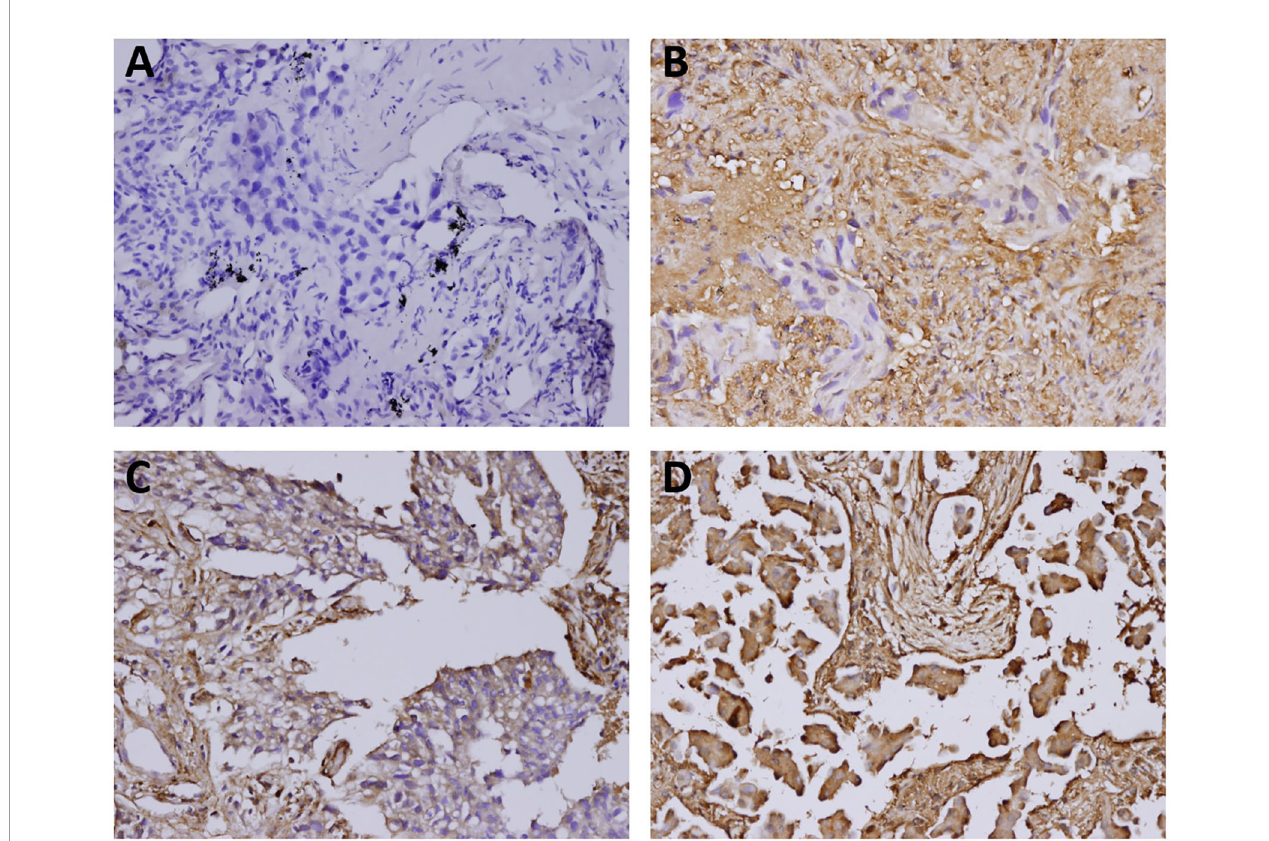
FIGURE 1 | The immunostaining features of tumor galectin-1 expression. The percentages of positive staining for galectin-1 in the tumor part were scored as follows: (A) Score 0 for <10% positive staining; (B) Score 1 for 10% to <40% positive staining; (C) Score 2 for 40% to <70% positive staining; (D) Score 3 for at least 70% positive staining. Original magni fi cation